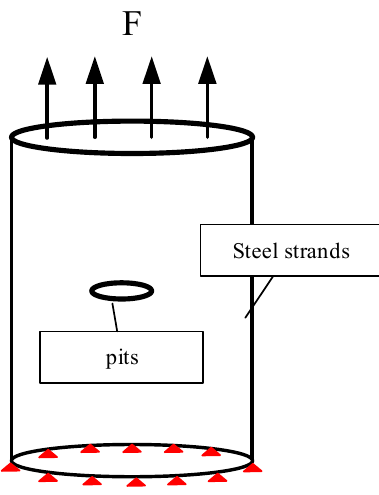
Figure 14. Schematic diagram of model loading.